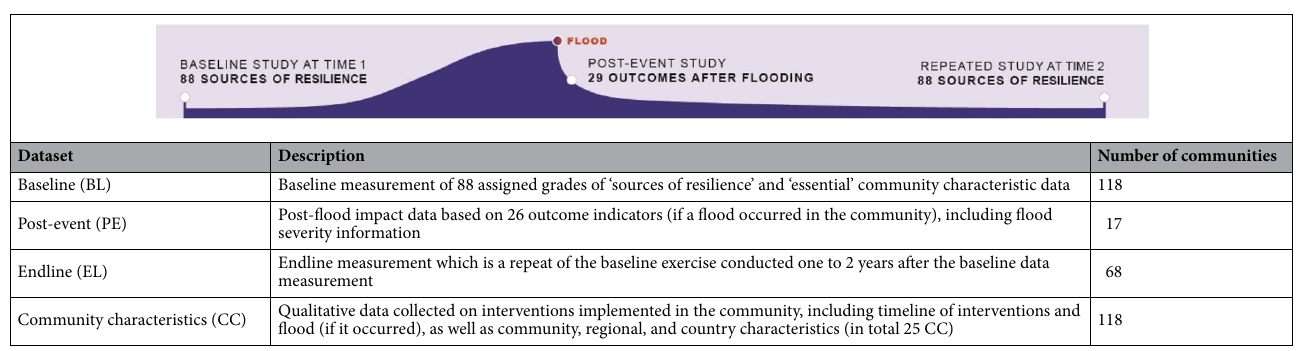
Table 1. Datasets over time periods and community characteristics used for analysis. Adapted from 14